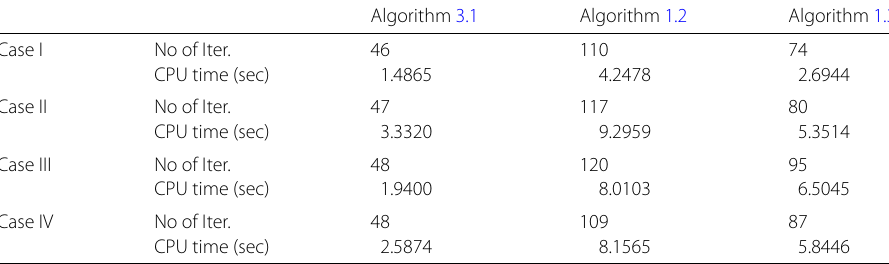
Table 2 Computational result for Example